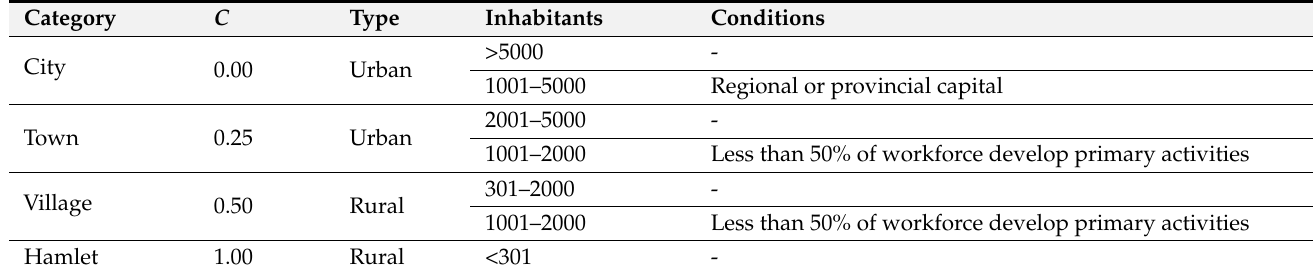
Table 2. Definition of category and type of coastal settlement, adapted from [37]. The parameter C weights the type of settlement in the sensitivity index given by Equation